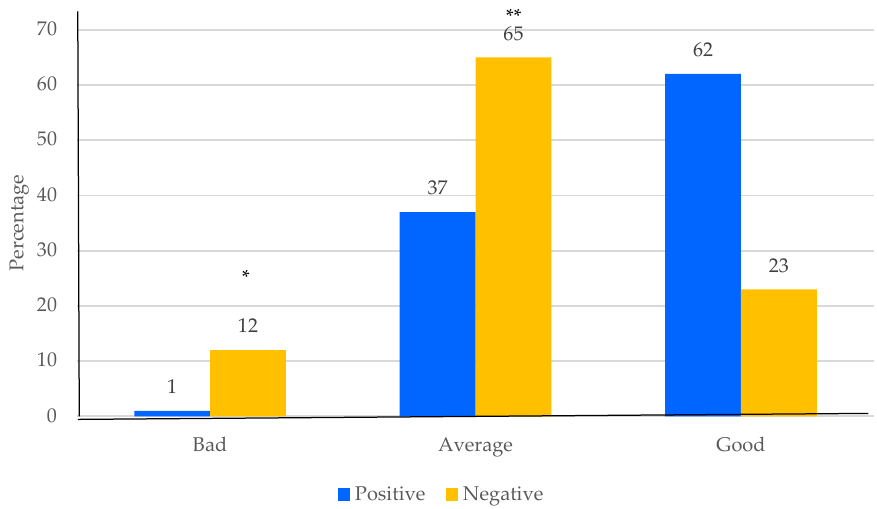
Figure 3. Frequency of self-perception of aging with different levels of quality of life in the psycho- logical subscale. Chi squared test * bad vs. good quality of life, p < 0.001; ** average vs. good quality of life, p < 0.05.